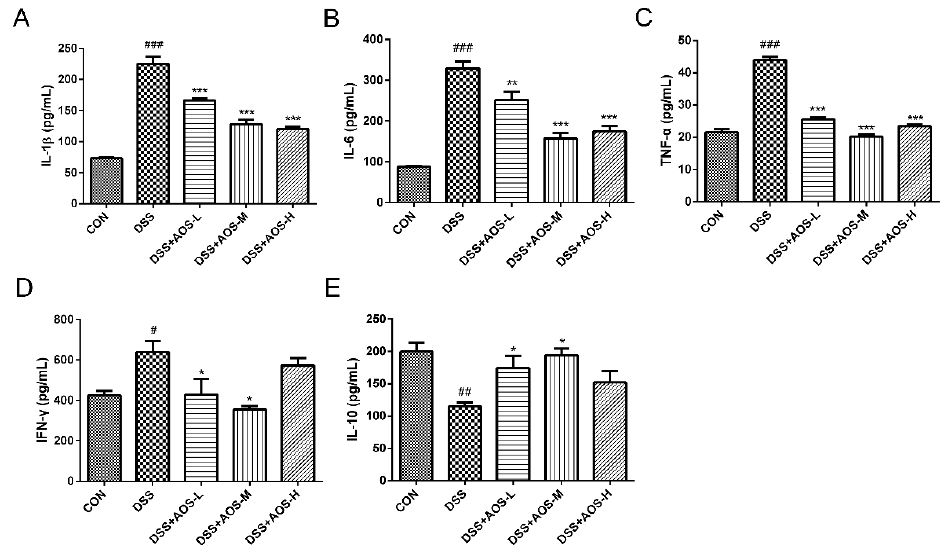
Figure 4. Effects of AOS on the production of proinflammatory cytokines in vivo as detected by ELISA analysis of the levels of IL-1 β ( A ), IL-6 ( B ), TNF- α ( C ), IFN - γ ( D ), and IL-10 ( E ) in the serum of DSS-induced acute colitis mice. * p < 0.05, ** p < 0.01, *** p < 0.001 vs. DSS group; # p < 0.05, ## p < 0.01, ### p < 0.001 vs. Control group; n = 6.